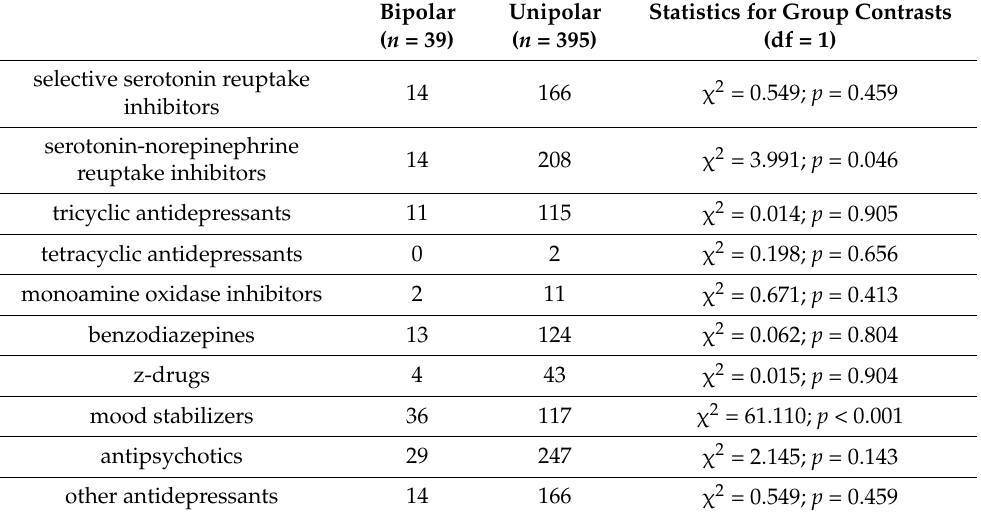
Figure 2. Absolute change in HDRS-21 subitems for bipolar and unipolar depressed patients. Asterisk (*) denotes items for which p < 0.05. Table 2. Medication